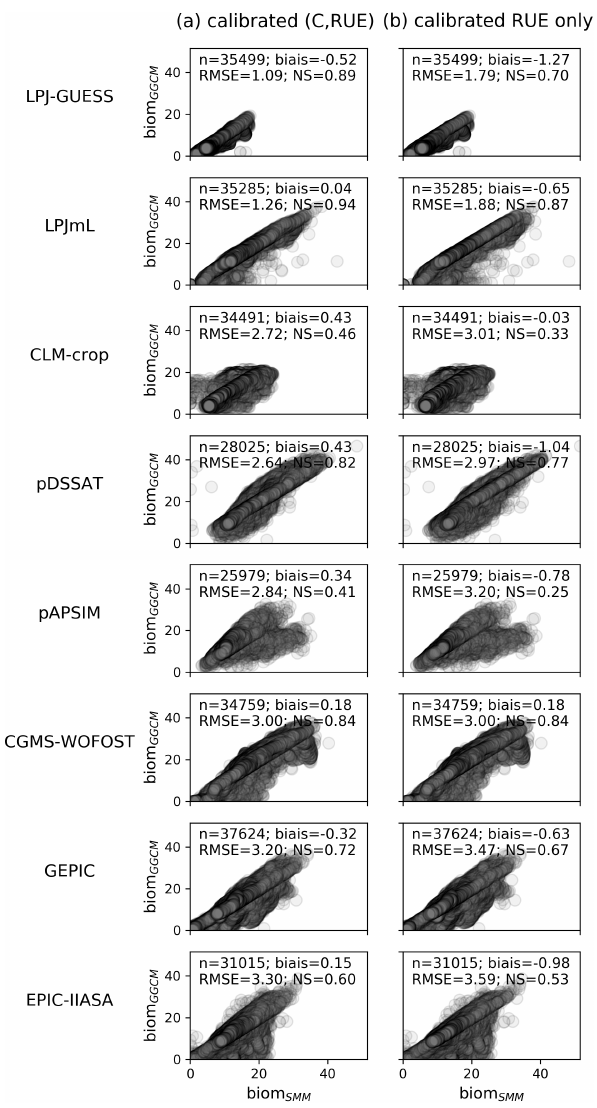
Figure 5. Scatterplots of biom GGCM ( y axis) vs. biom SMM ( x axis) after SMM calibration, i.e., calibration of global GGCM-dependent ( C , RUE) and spatially varying GDD 1leaf . In (a) the ( C , RUE) pair that minimizes the most the RMSE is used, while in (b) the ( C , RUE) minimizing the RMSE with C equal to its initial estimate (the so-called fourth pair in Sect. 2.2.4) is used. Each dot corresponds to one grid cell. In the top left of each panel, the number of grid cells considered ( n ) and the different quantifications of the SMM vs. GGCM agreement (bias, RMSE, and NS) are given. See Fig. S6 in the Supplement for scatterplots of the four ( C , RUE) pairs.